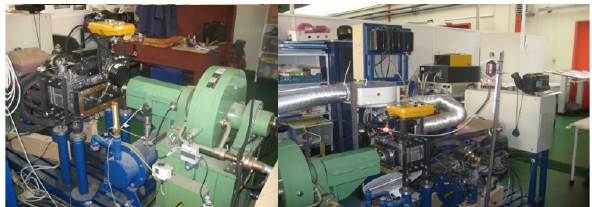
Figure 5: Overview of the dynamometric test bench and the oppos- ing piston